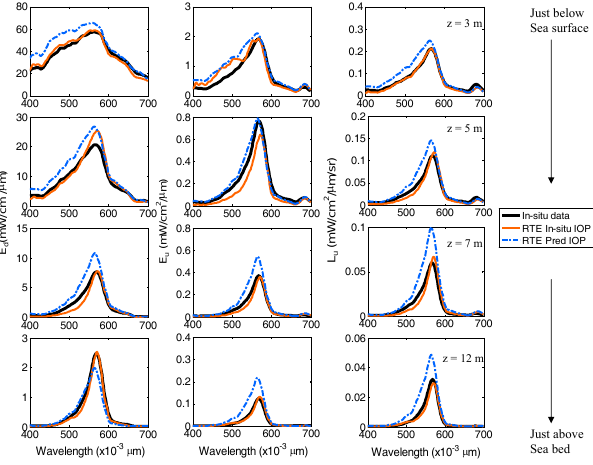
Figure 13. Spectral comparisons of the simulated and measured un- derwater light fields ( E d , E u and L u ) for four discrete depths in turbid coastal waters off Point Calimere (St-4). The black colour represents the measured data, orange colour represents results from the present RT model using in situ IOP data, and the blue colour represents results from the present RT model using the predicted IOPs from the remote-sensing reflectance data.